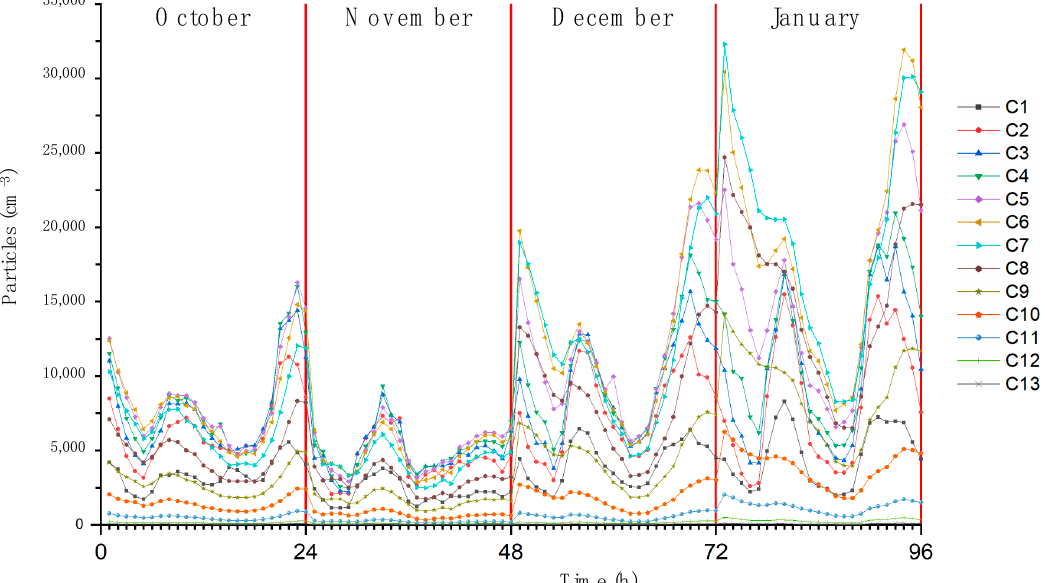
Figure 4. Daily behavior of the different fraction sizes in the range 18–750 nm over the whole investigated period (C1: 17.8 nm; C2: 23.7 nm; C3: 31.6 nm; C4: 42.2 nm; C5: 56.2 nm; C6: 75.0 nm; C7: 100.0 nm; C8: 133.4 nm; C9: 177.8 nm; C10: 237.1 nm; C11: 316.2 nm; C12: 422.7 nm; C13: 562.2 nm).